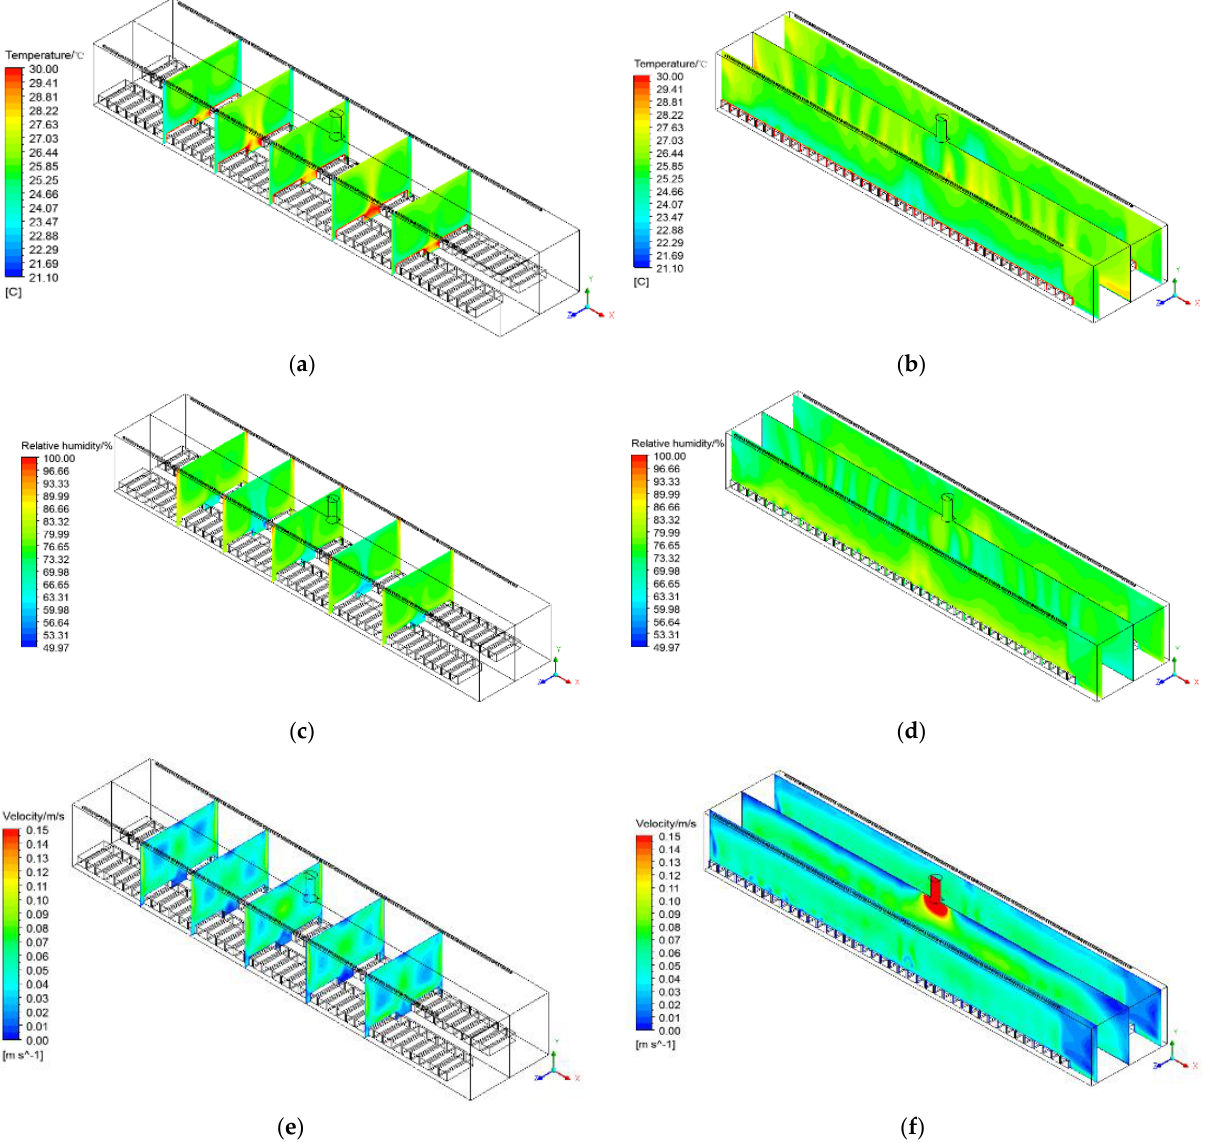
Figure 9. Airflow distribution of ( a ) temperature, ( b ) humidity, and ( c ) velocity in longitudinal sections and of ( d ) temperature, ( e ) humidity, and ( f ) velocity in horizontal sections. Table 3. Results for comparison of the two outlet positions.